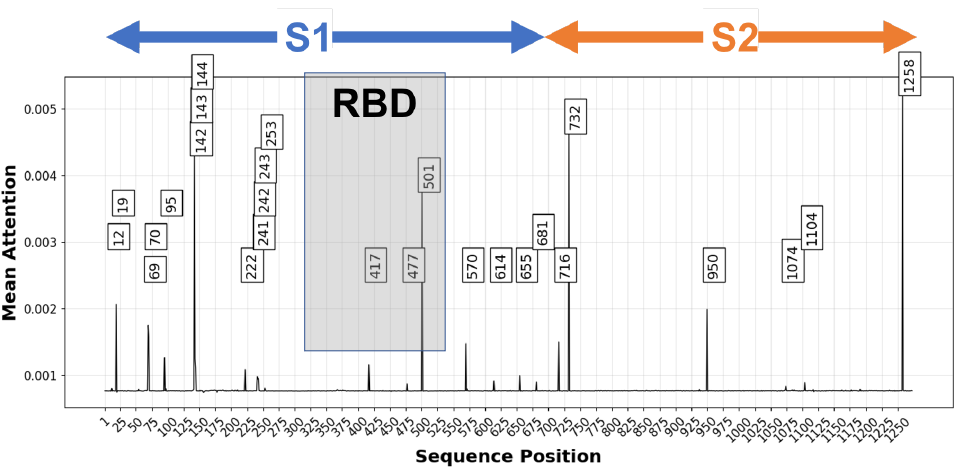
Figure 7. Mean attention at each spike protein sequence position of validation samples. Labeled positions have attention scores above 0.0008. The graph approximate locations for the S1 and S2 subunits, which is cleaved at a furin cleavage site (positions 680-689) by host proteases leading to membrane fusion and host cell entry [4]. The receptor binding domain (RBD) (391-541) is also shown [94]. Many high attention sites are clustered to the N-terminal domain (NTD) and C-terminal domain (CTD) of the S1